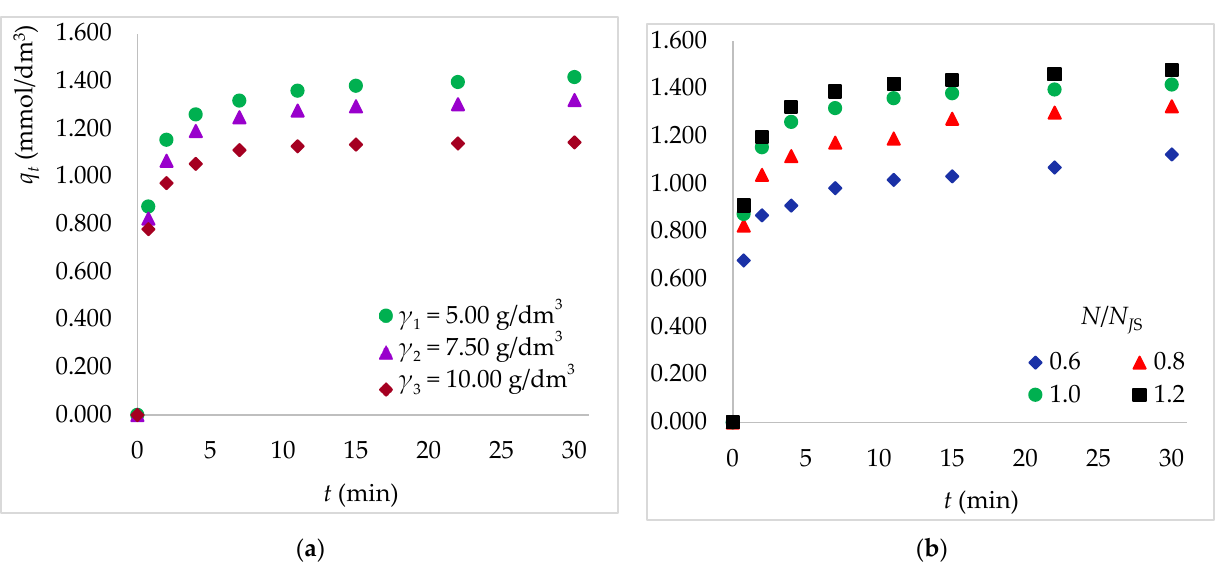
Figure 8. Amount of copper (II) ions retained on the zeolite as a function of time ( a ) comparison of experimental data for three mass concentration of zeolite suspension ( b ) comparison of experimental data for four N / N JS ratios and zeolite mass of 10.50 g. Note: standard deviation for measured concentrations of copper in samples were in the range from 0.001 to 0.185 and for calculated q e from 0.000 to 0.038; number of repetitions is three.